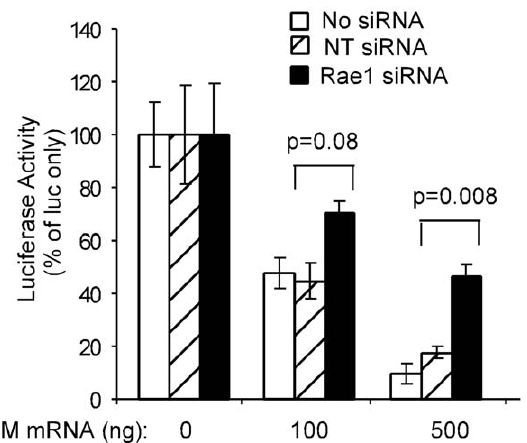
Figure 9. Effect of silencing Rae1 expression on the inhibition of host gene expression by M protein expressed in the absence of other VSV components. HeLa cells were either not transfected or transfected with Rae1 siRNA or non-targeting (NT) siRNA. After 48 hours, cells were re-seeded, then cotransfected with plasmid DNA encoding luciferase under the control of the SV40 promoter together with the indicated amounts of M mRNA. The amount of total RNA was kept constant by addition of yeast tRNA. At 24 hours post-transfection, cells were lysed and luciferase reporter activity was measured. The graph represents activity expressed as a percentage of average luciferase activity in the absence of M mRNA. Data shown are means 6 standard deviation from three independent experiments.